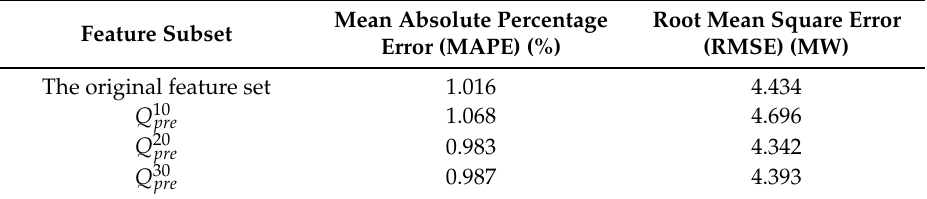
Table 4. Prediction error of different feature subsets selected for 1-h-ahead prediction.